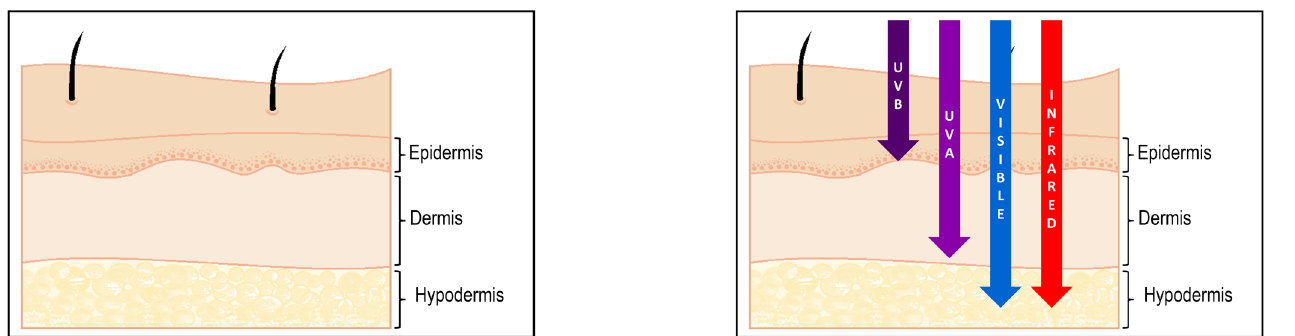
FIGURE 1 - Skin’s main layers: Epidermis, dermis and hypodermis, 1A . Electromagnetic radiation emitted by the sun and its ability to penetrate the skin layers,